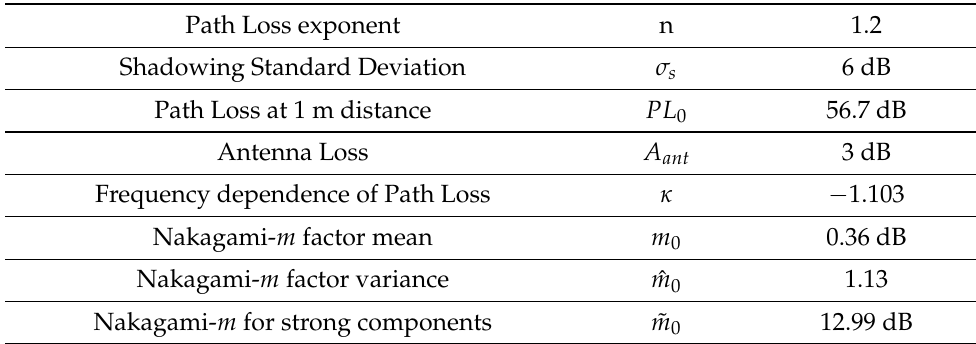
Table 1. The path loss and small-scale fading parameters for the simulated line of sight (LoS) Industrial ultra-wide bandwidth (UWB) channel, as mentioned in [53,54].